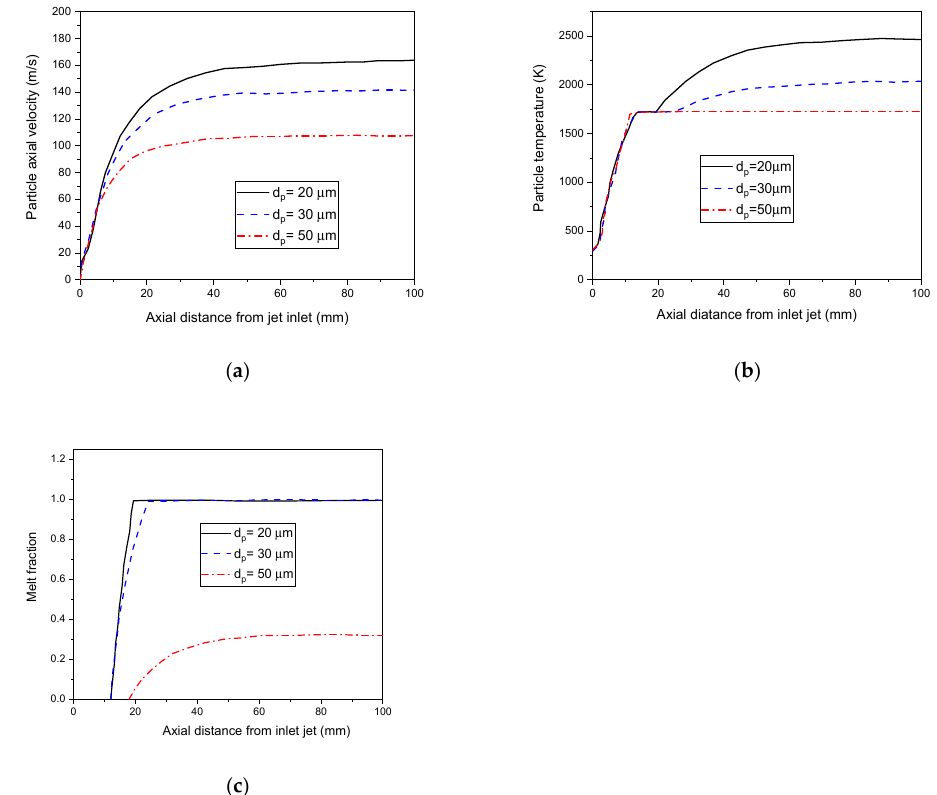
Figure 14. Axial velocities ( a ), surface particle temperature ( b ), and melt fraction ( c ), with different particles diameters in the plasma jet (10 µm, 20 µm, 30 µm). 4.4.3. Particles Number Figure 15 represents the particle’s path and temperature with several numbers of particles (N p = 3000, 5000, and 10,000). For a higher number of particles, total momentum and energy exchanges increase, and the injected particles assume deeper penetration during their motion in the gas channel (see Figure 15a). This then results in a higher particle temperature. (Figure 15b).